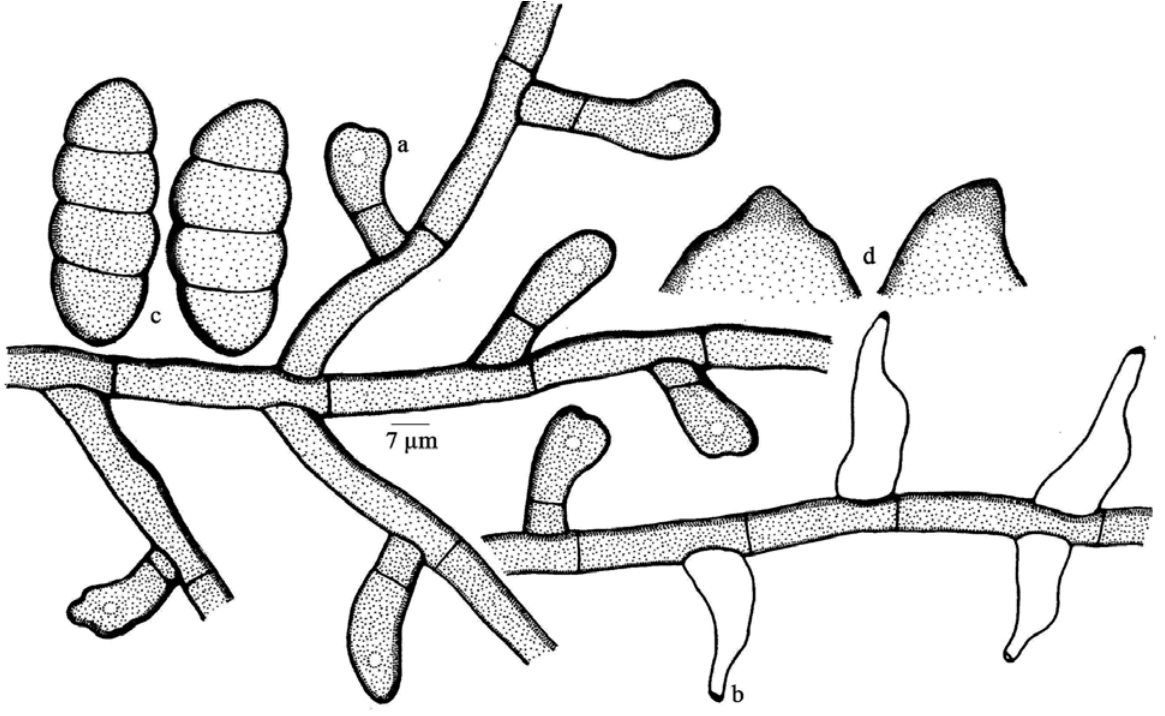
Figure 2. Asteridiella shenbaganurensis sp. nov. a - Appressorium; b - Phialide; c - Ascospores; d - Perithecial wall